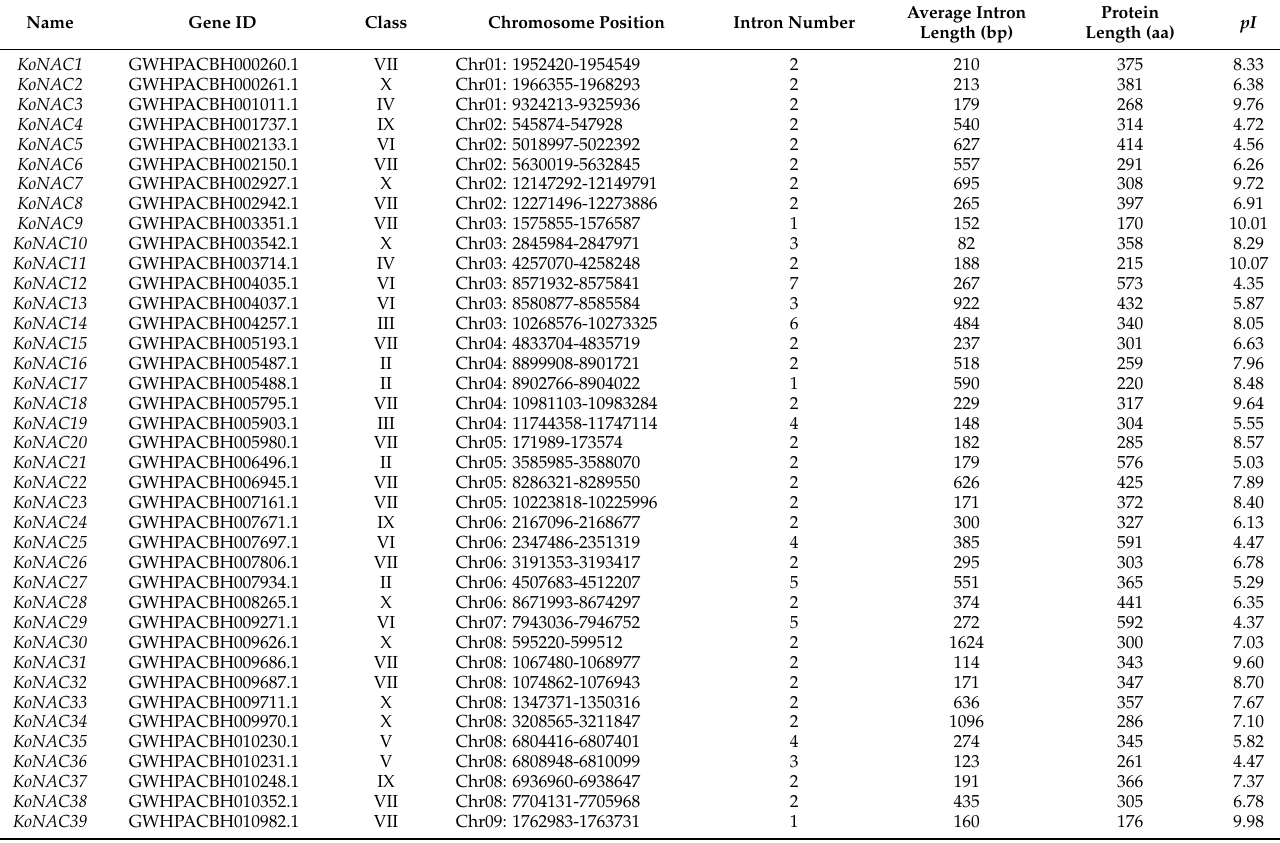
Table 1. Basic information of K. obovata NAC